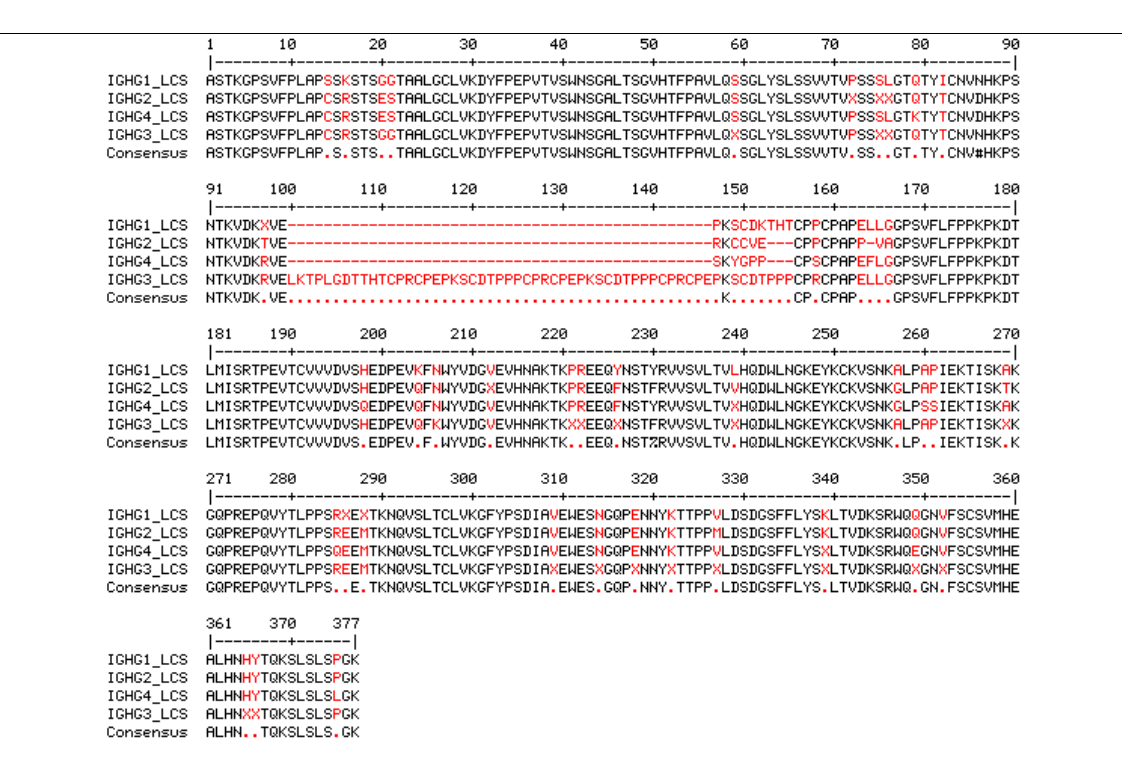
Figure 1. Schematic representation of the Ig domains of the individual polypeptide chains of IgG1 molecule. disulfide bonds are highlighted in yellow; complementarity-determining regions (CDR) are highlighted by red triangles. The papain-cleavage site is indicated by a bold arrow.